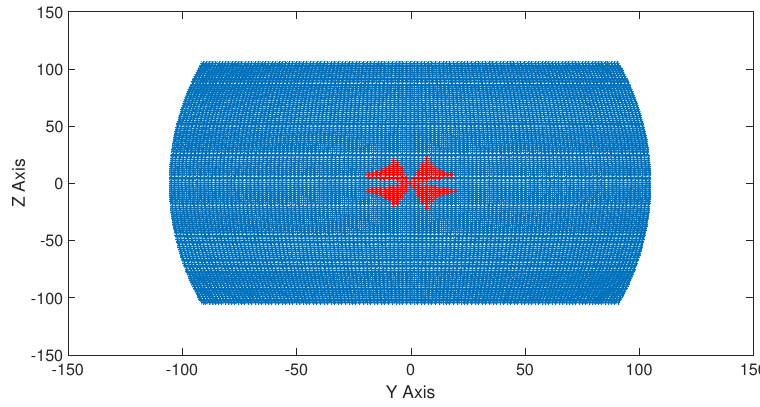
Figure 7. Y–Z plane of the workspace for the class 2 tensegrity robot.